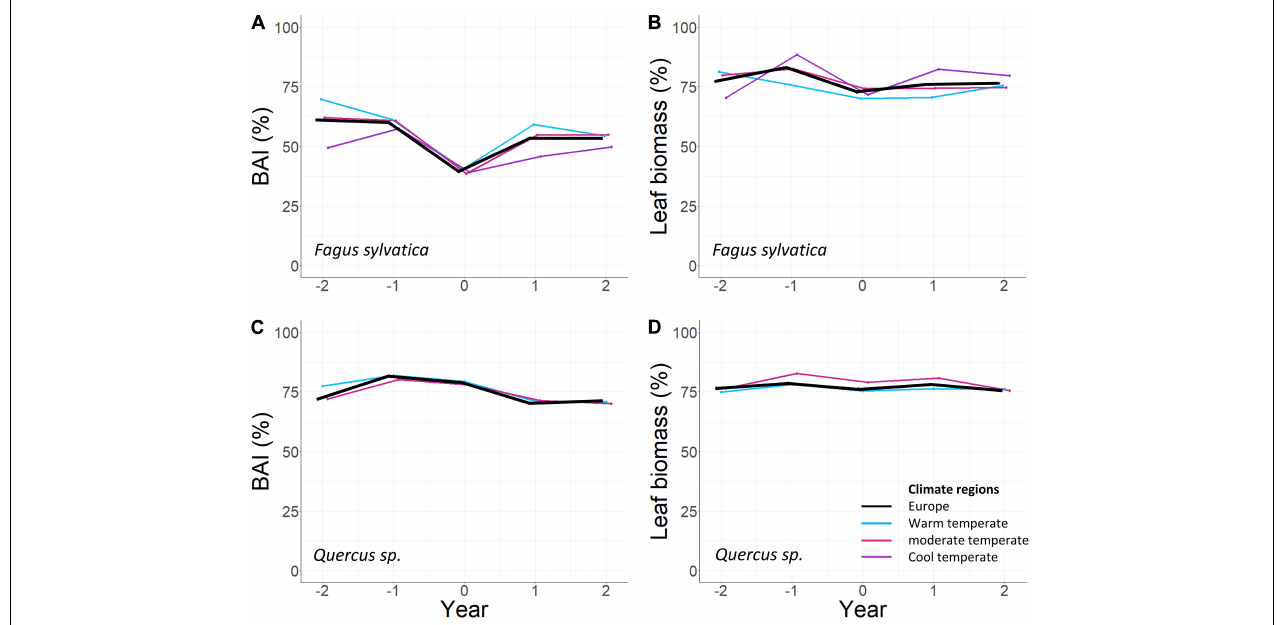
FIGURE 3 | Superposed epoch analyses (SEA) for Europe and climate regions: (A) basal area increment in Fagus sylvatica , (B) leaf biomass in Fagus sylvatica , (C) basal area increment in Quercus sp., (D) leaf biomass in Quercus sp. SEA investigate the relations of a parameter in focal years (Year 0) to the same parameter in the previous and subsequent years (Year–2 = 2 years before mast year, Year–1 = 1 year before mast year, Year 0 = mast year, Year + 1 = 1 year after mast year, Year + 2 = 2 years after mast year). All values in percent of the maximum value per plot. Threshold level for mast year definition: 60% of the maximum of measured fruit biomass per plot. For better visibility the curves are displayed slightly offset. BAI: Basal area